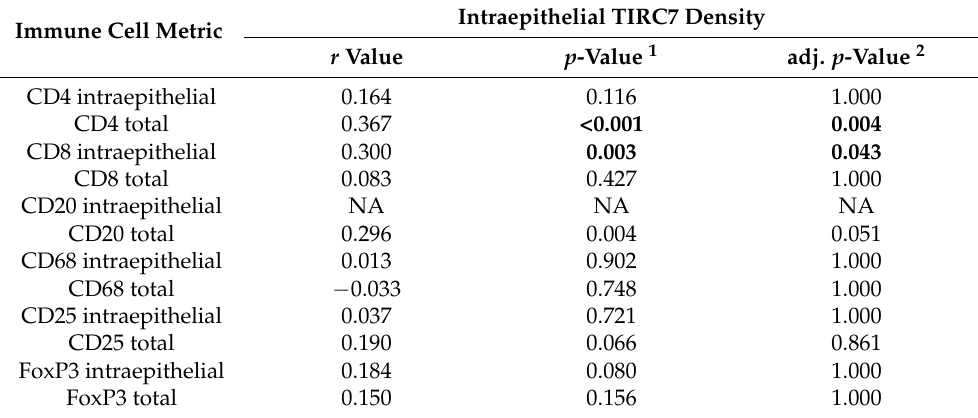
Table 2. Association of intraepithelial TIRC7+ immune cell density with immune cell